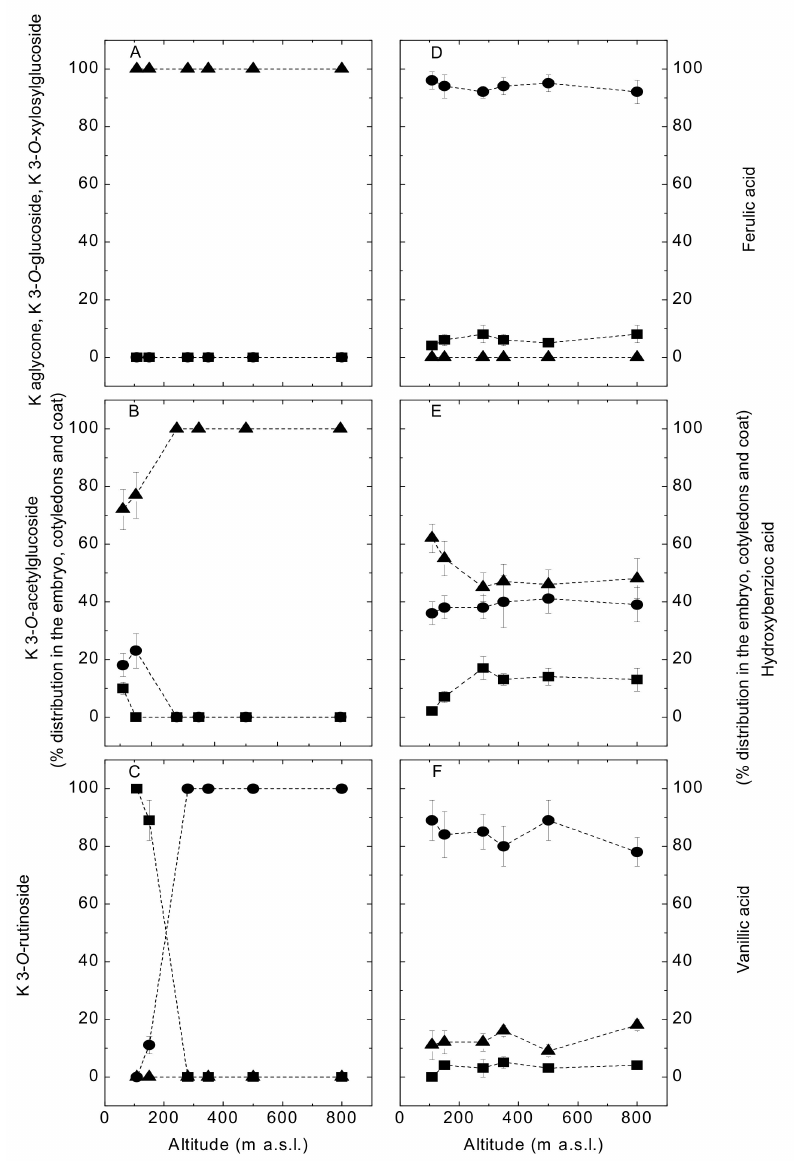
Figure 2. Distribution (%) in the seed coat ( (cid:78) ), cotyledons ( • ) and embryonic axis ( (cid:4) ) of ( A ) kaempferol aglycone, kaempferol 3- O -glucoside and kaempferol 3- O -diglucoside, ( B ) kaempferol 3- O acetylglucoside, ( C ) kaempferol 3- O -rutinoside, ( D ) ferulic acid, ( E ) p- hydroxybenzoic acid, and ( F ) vanillic acid of “Zolfino del Pratomagno” at di ff erent altitudes. For each altitude, n =